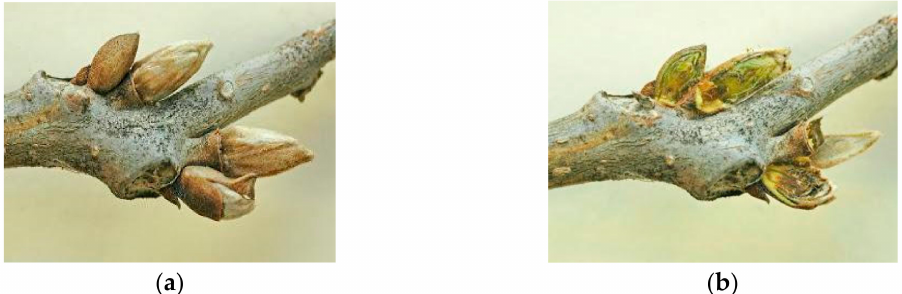
Figure 2. After low temperature on 16 April 2018 (4 ◦ C): ( a ) ‘Kanza’ buds, 20 June 2018; appear to be dormant. ( b ) Dissection of same ‘Kanza’ bud with brown streaks indicating freeze injury [43].